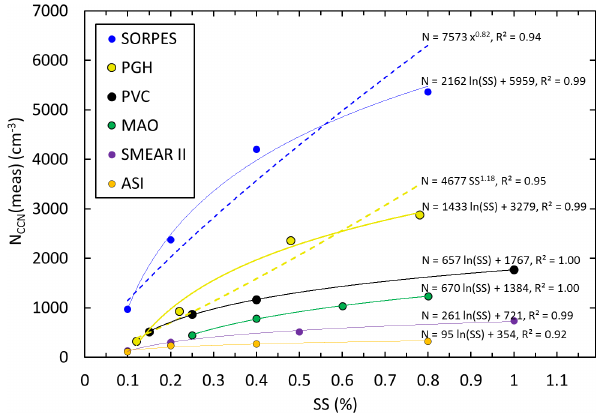
Figure 1. Averages of the measured N CCN at the six sites at the station-specific supersaturations of the CCN counters and logarith- mic (solid lines) and power function (dashed lines) fittings to the